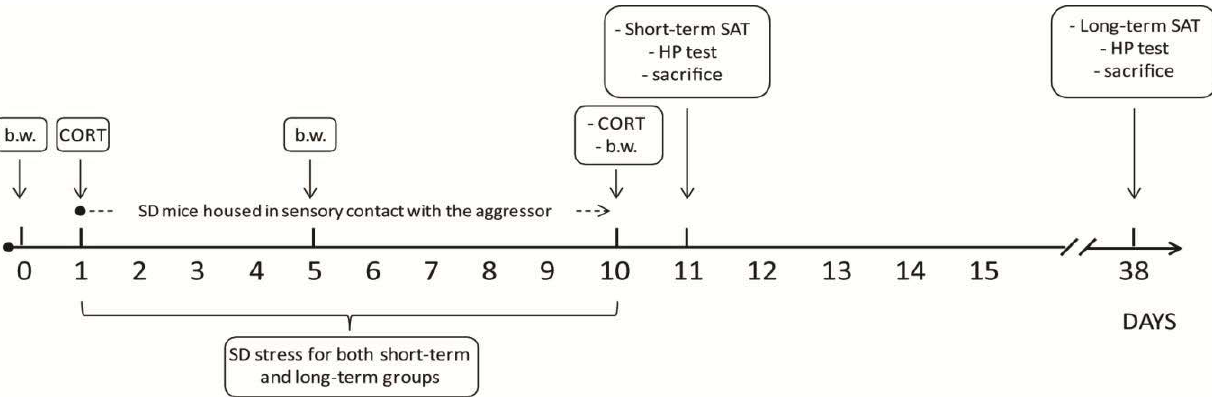
Figure 1. Schematic representation of the experimental timeline. The experiment lasted 38 days in total. SD subjects underwent 10 days of daily bouts of social defeat, followed by continuous protected sensory contact with their aggressor. Body weight was assessed on the day before stress took place (day 0), on day 5 and on day 10 of SD. Blood samples for corticosterone assessment were collected on days 1 and 10. SD and CTRL subjects were either tested on day 11 (24 h following the end of the SD procedure, short-term effects of stress), or on day 38 (4 weeks following the end of the SD procedure, long-term effects of stress). b.w.: body weight; CORT: corticosterone; SAT: Social Avoidance Test; HP: Hot Plate Test; SD: Social